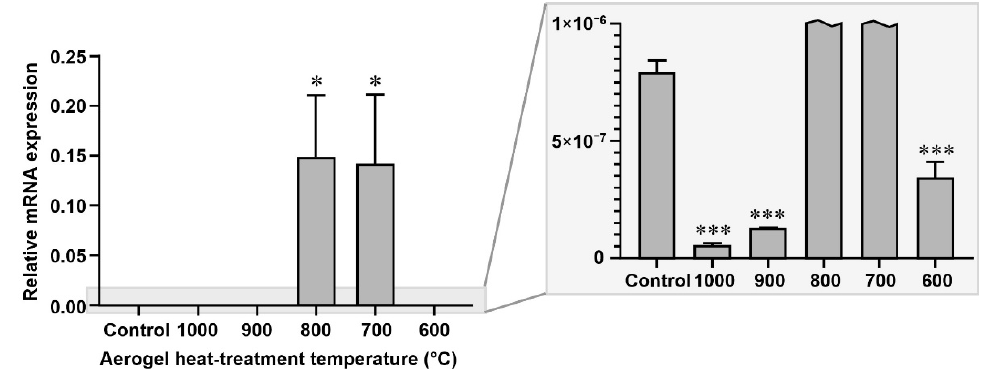
Figure 10. The effects of the differently heat-treated aerogel composites on the type I collagen mRNA expression of MG63 cells cultured for 14 days as measured by RT-qPCR. Values are expressed as sample means; error bars represent the estimates of standard deviations calculated from three parallel measurements compared to the control (* p < 0.05, *** p <